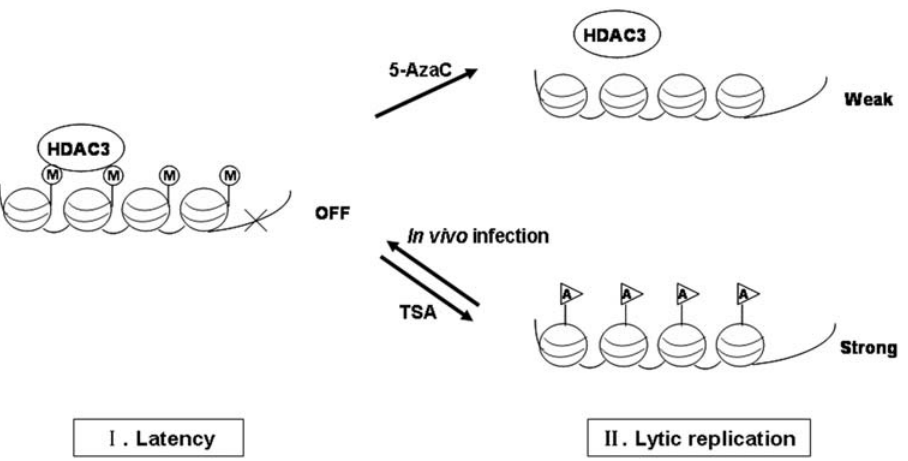
Figure 8. A working model for DNA demethylation and histone acetylation regulation of MHV-68. (A) In S11E cells or latent infection in vivo , the RTA promoter is methylated and HDAC3 complex is recruited to the RTA promoter to suppress transcription. (B) When treated with TSA, the HDAC3 complex is rapidly removed, the RTA promoter demethylated through a passive mechanism, and RTA transcription is turned on. (C) However, when treated with 5-AzaC, though the RTA promoter becomes demethylated, HDAC3 stays at the promoter and the RTA promoter remains suppressed. M: methylation; A: acetylation.